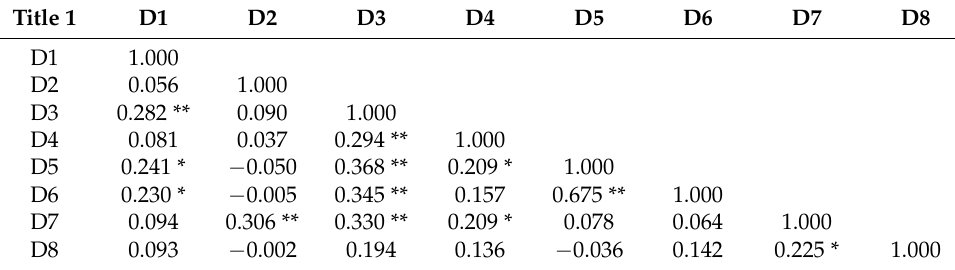
Table 4. Analysis of the correlation between dimensions.